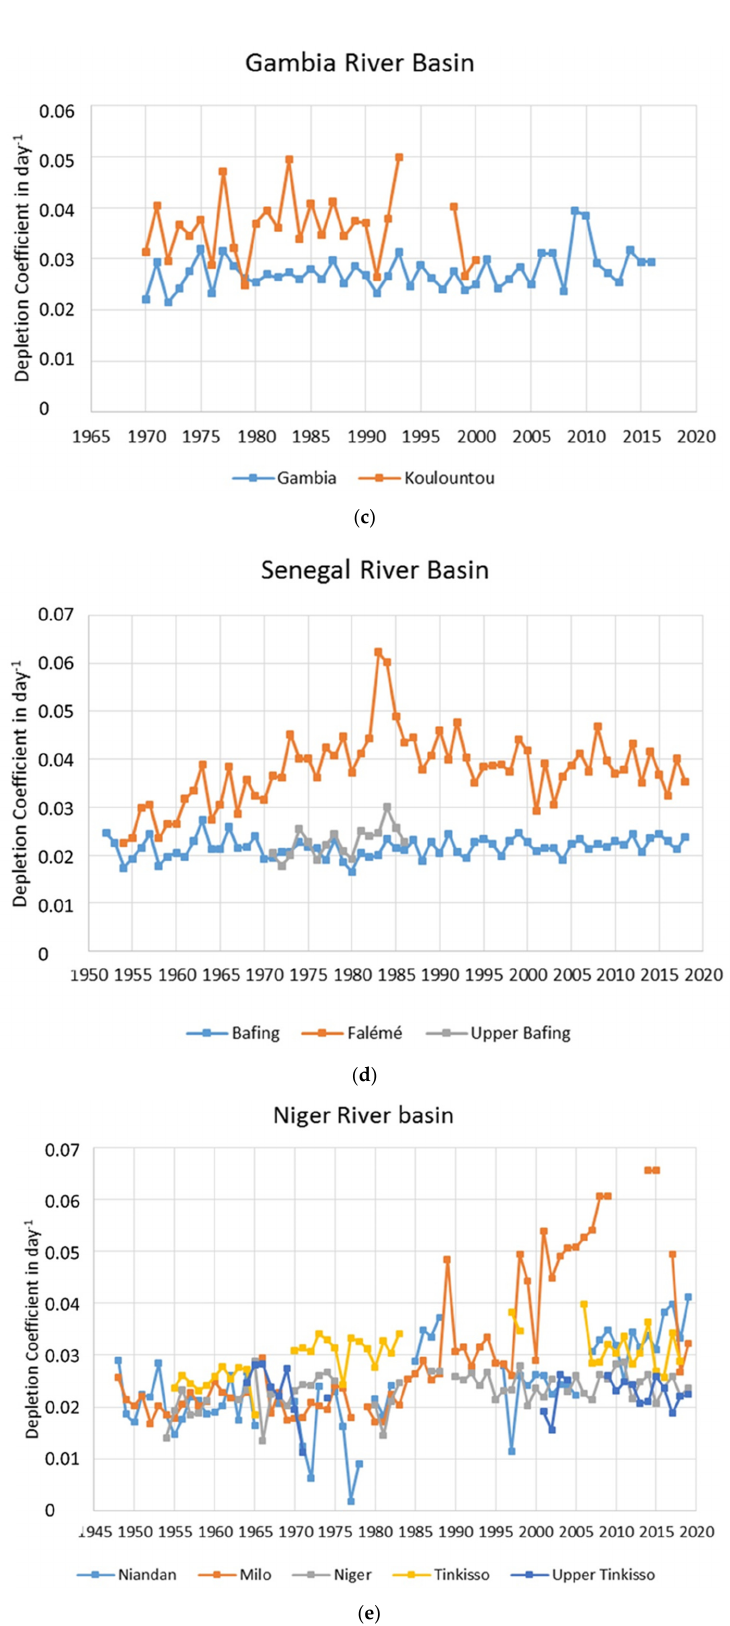
Figure 6. Dynamic of depletion coefficients for the period 1947–2018, by basin; ( a ) Konkouré River basin; ( b ) Koliba/Tominé/Corubal River basin; ( c ) Gambia River basin; ( d ) Senegal River basin; ( e ) Niger River basin.